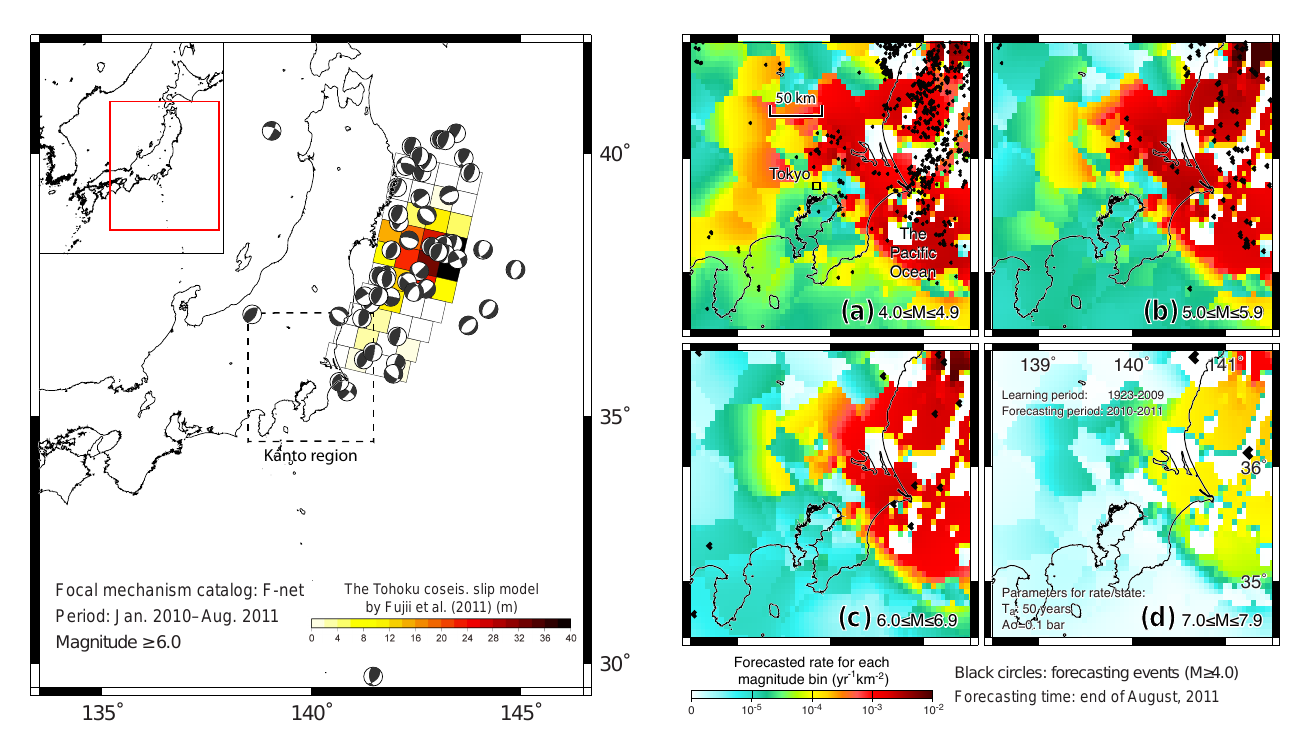
Figure 5. Distribution of the M ≥ 6.0 earthquakes, which took place in or near the Kanto region during January of 2010 and August of 2011. The coseismic dislocation model of the 2011 M 9.0 Tohoku earthquake is obtained by tsunami waveform inversion (Fujii et al., 2011), whereas the focal mechanisms of the others are obtained from the F-net catalogue.